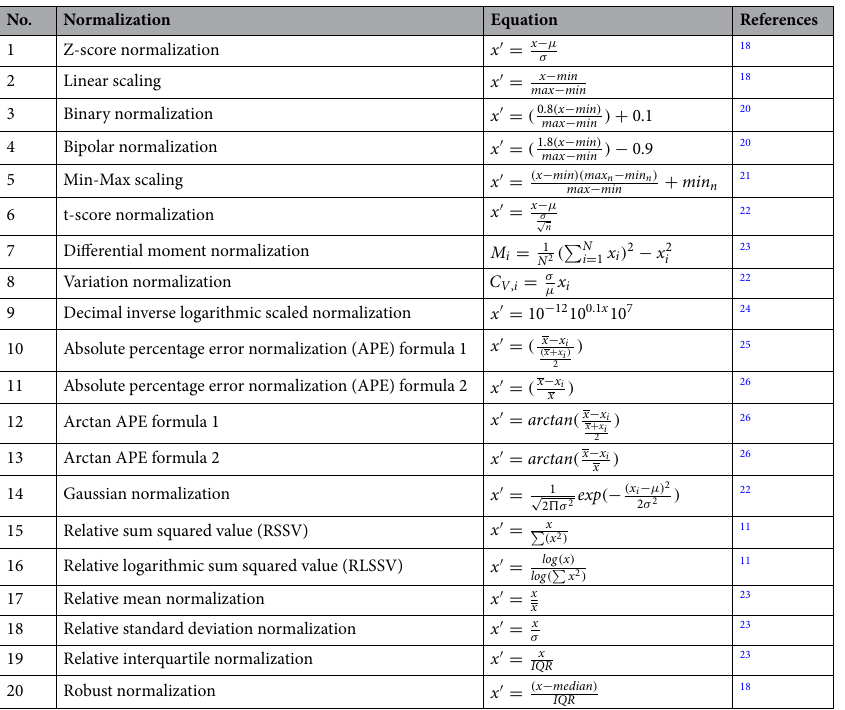
Table 1. Normalization methods